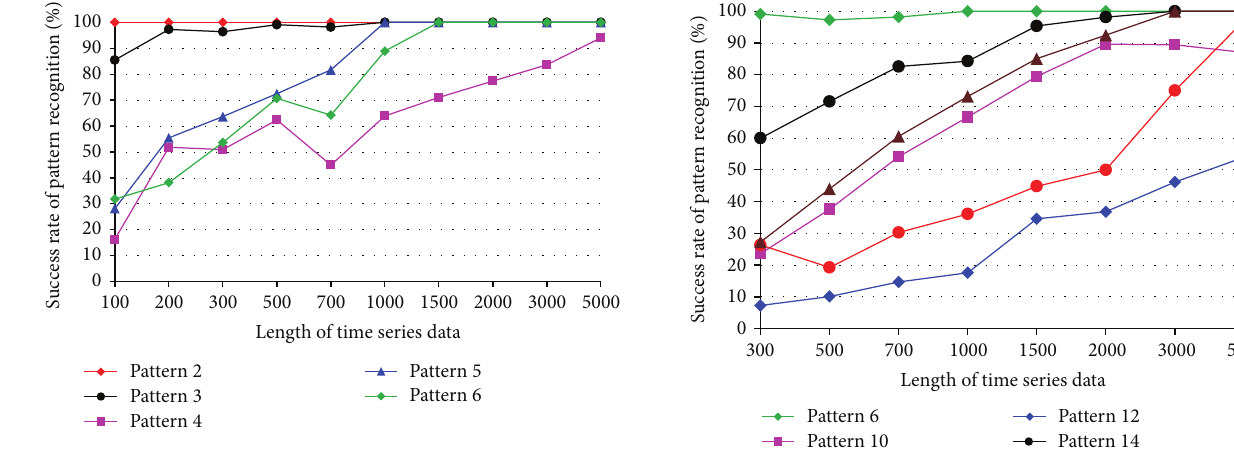
Figure 18: Success rate of pattern recognition using DWT-based feature extraction in first scenario (sensor 232).